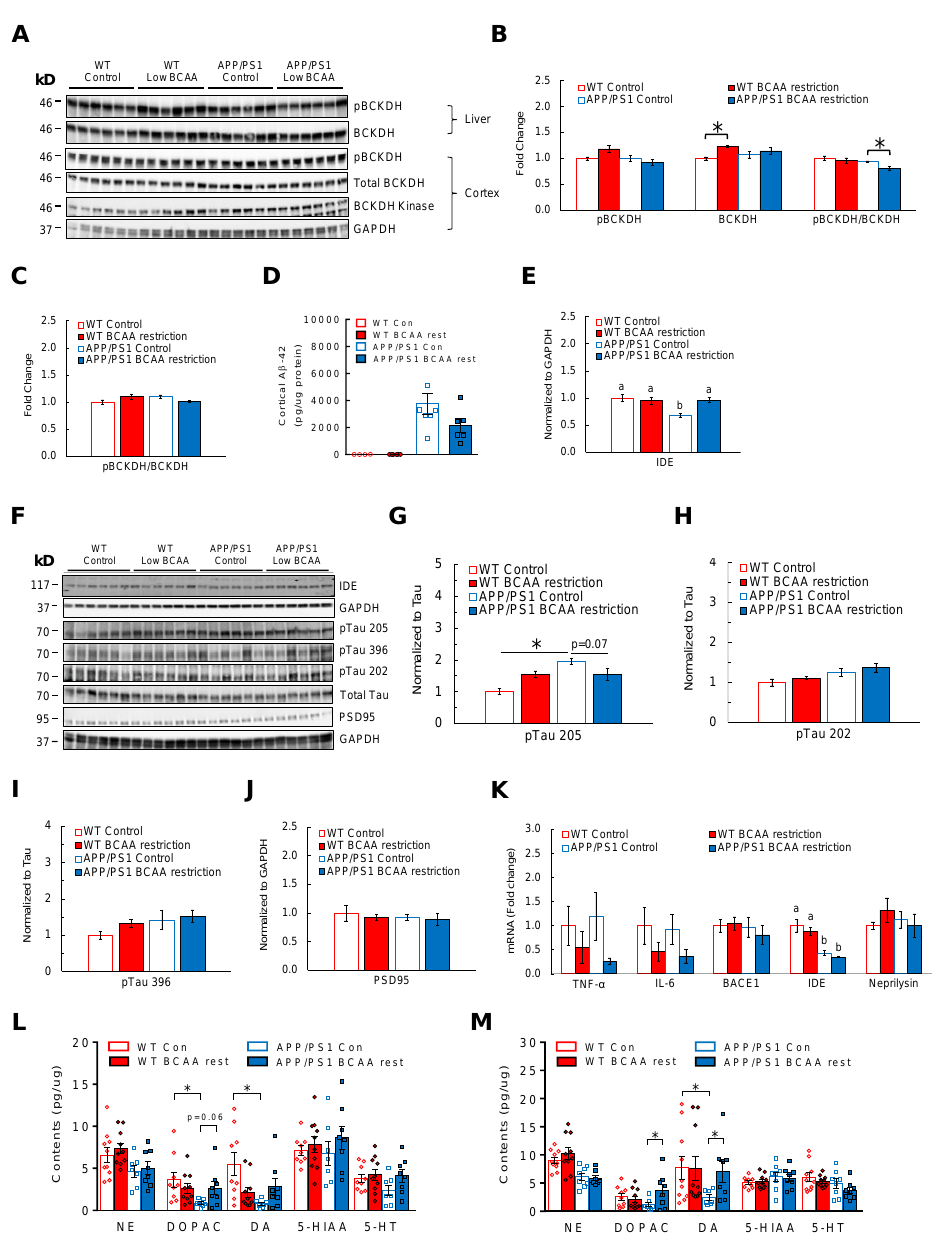
Figure 5. BCAA restriction lowers brain pathology and restores neurotransmitter content in APP/PS1 mice. 11-month-old WT or APP/PS1 mice without cognitive impairment were placed on a control or BCAA-restricted (50%) diet that is iso-caloric and iso-nitrogenous for two months. ( A ) Western blots for proteins involved in BCAA degradation in liver and cortex of the brain. ( B ) pBCKDH and total BCKDH in liver at the end of two months. ( C ) BCKDH inactivity index (pBCKDH/BCKDH) in the cortex. ( D ) Cortical Aβ -42 levels normalized to protein by ELISA. ( E ) Insulin-degrading enzyme (IDE) in the cortex of the brain. ( F ) Western blots for IDE, PSD95, and phosphorylated Tau in the cortex. ( G ) Phosphorylated state of Tau at threonine residue 205, ( H ) Serine residue 202, and ( I ) Serine residue 396. ( J ) Protein expression of PSD95. ( K ) Analysis of genes involved in neuroinflammation and amyloid production and degradation, normalized to B2M. ( L ) Monoamine neurotransmitter concentrations in the hippocampus and ( M ) Cortex. NE — Norepinephrine; DA — Dopamine; DOPAC — Dopamine metabolite; 5-HT — Serotonin; 5-HIAA — Serotonin metabolite. * p < 0.05. Groups with different letters are significantly different from each other with p < 0.05.